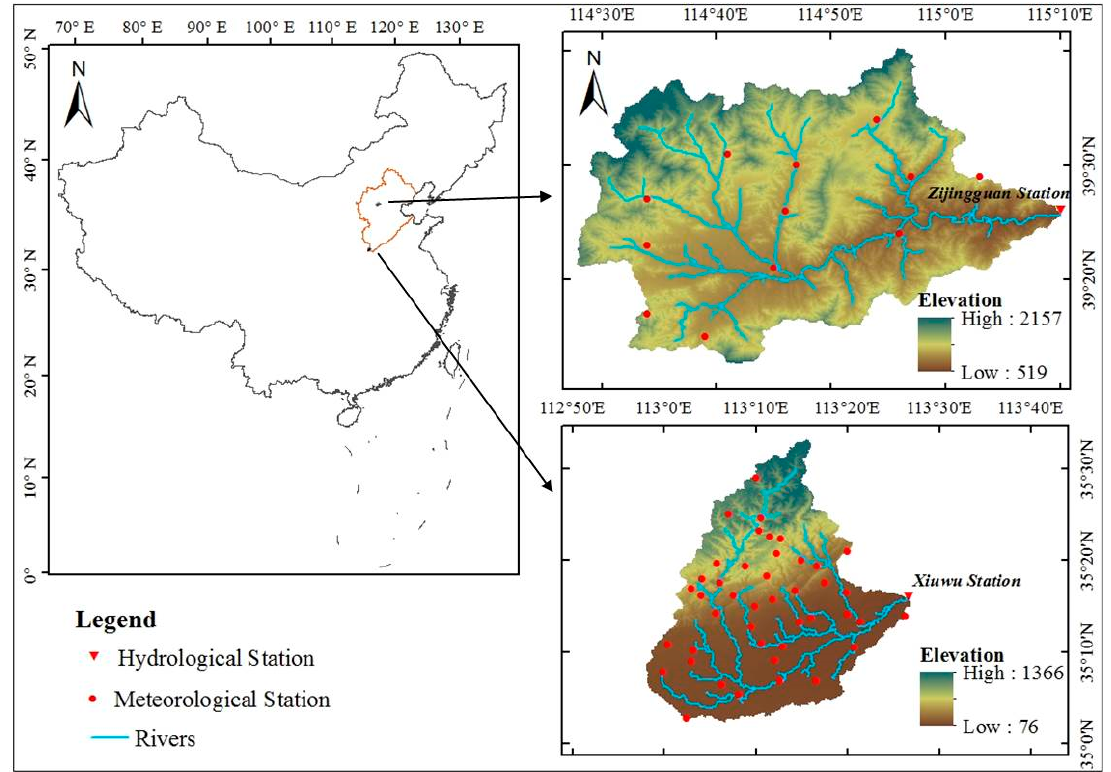
Figure 3. Map of the Zijingguan basin and the Xiuwu basin located in Haihe River Basin, China.